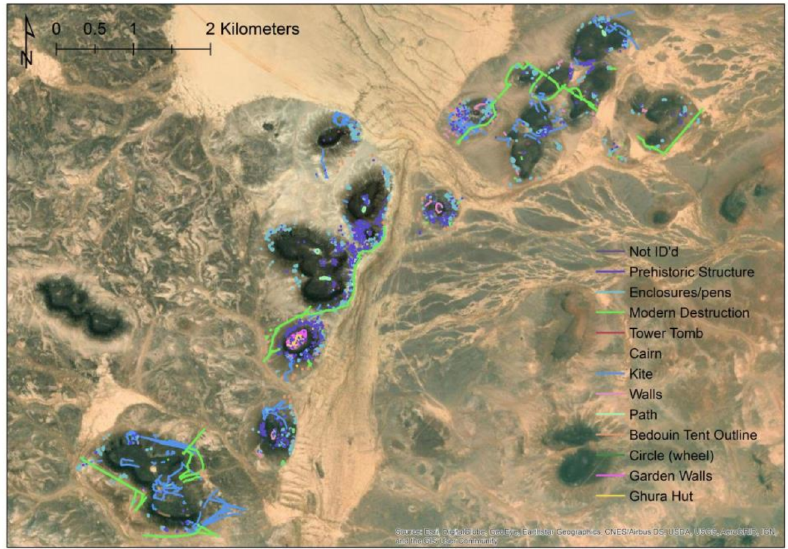
Figure 9. Overview of the Wadi al-Qattafi survey database displayed against an Esri World Imagery basemap. The basemap is used as a background because the orthophotos are not continuous for the entire area (see above). Basemap source: Esri, DigitalGlobe, GeoEye, Earthstar Geographics, CNES/Airbus DS, USDA, USGS, AeroGRID, IGN, and the GIS User Community.